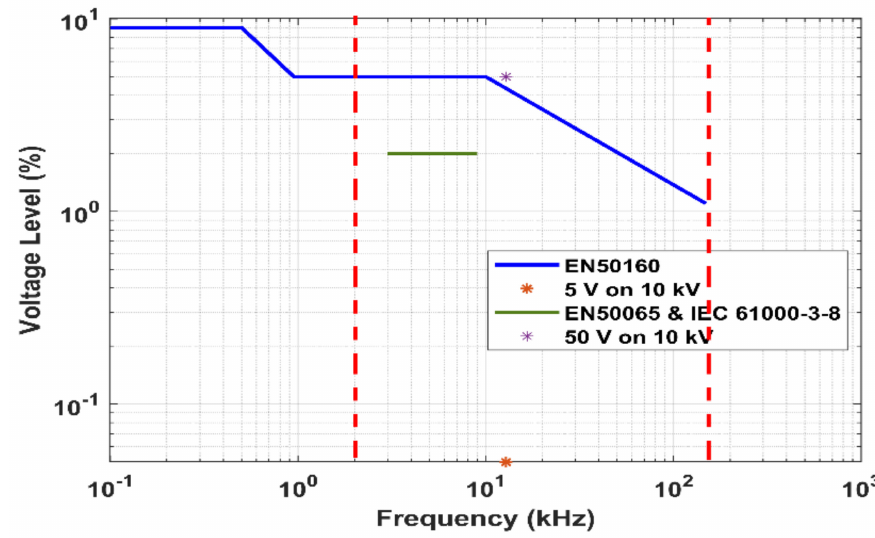
Figure 11. Emission limits at supraharmonics frequency range as per